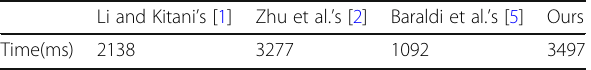
Table 2 Comparison with state of the art on time